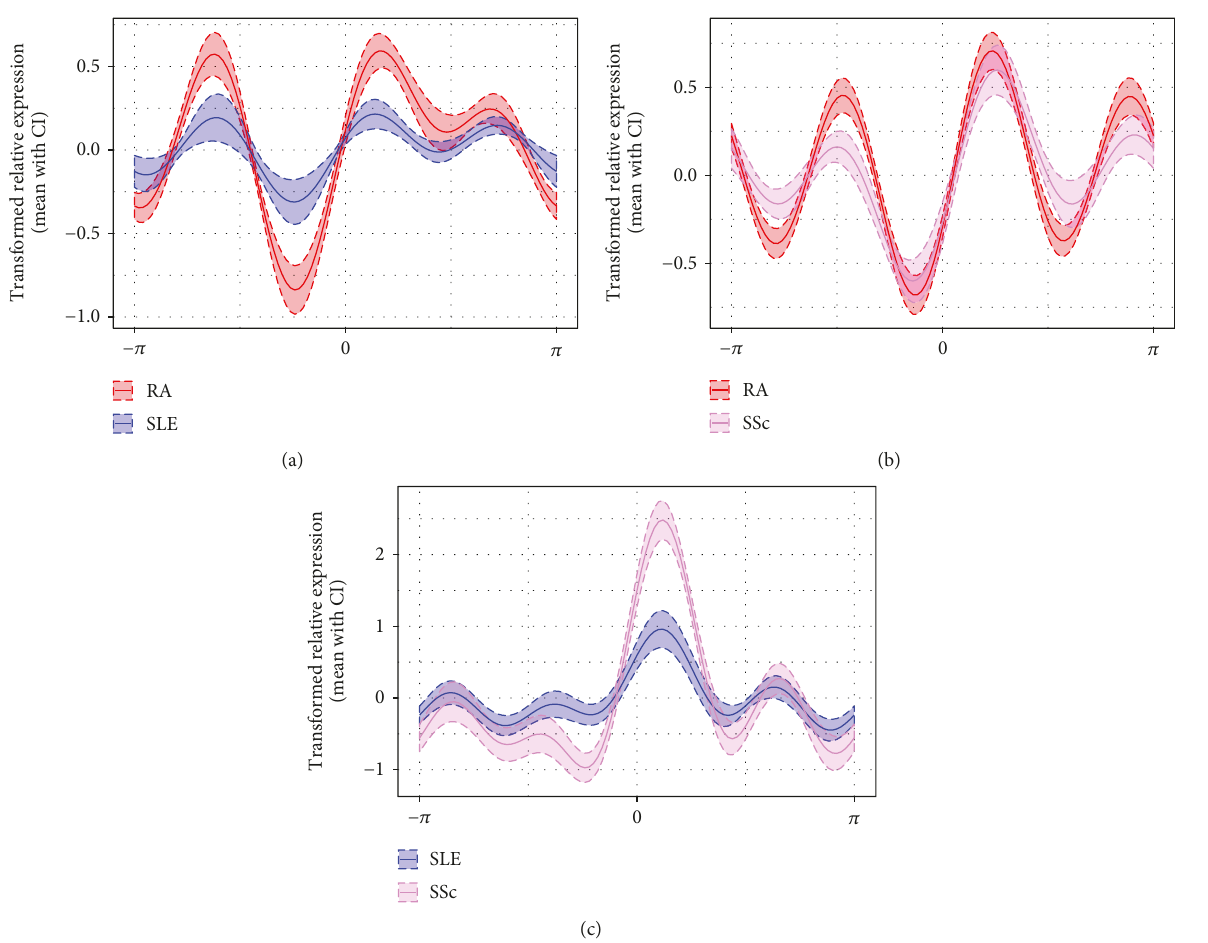
Figure 2: Di ff erential innate gene expression analysis by Andrews curves between (a) RA vs. SLE, (b) RA vs. SSc, and (c) SLE vs. SSc — representative examples. The Andrews curves were calculated for various combinations of gene expression values from the whole set of studied genes. Examples show the results of the Andrews curve analysis for the combination of (a) TLR3 , TLR7 , TLR8 , IL1R1 , IL1RN , and IL18R1 ; (b) TLR3 , TLR4 , TLR6 , TLR10 , IL1B , IL1R1 , and SIGIRR ; and (c) TLR4 , TLR6 , TLR7 , TLR8 , IL1R1 , IL1RN , and IL18 . For those sets of genes, a good separation of diseases was observed as visualized by separation of the curve ’ s amplitudes and phase shift. An example of combination of genes which does not discriminate between disease groups is shown in Figure S2. Full lines represent the mean values, the dashed lines 95% con fi dence